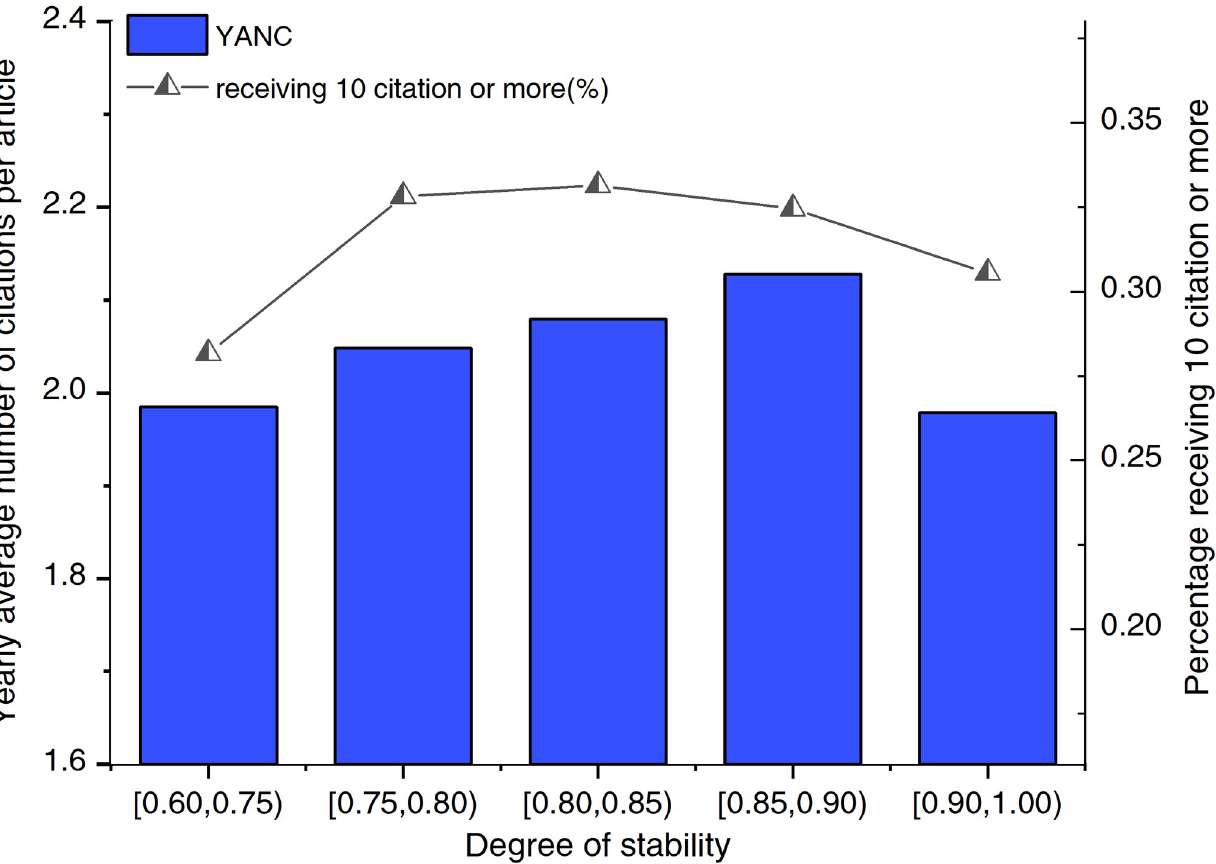
Fig 7. Yearly average number of citations (YANC) received and proportion of coauthored articles that have received at least 10 citations (CAP10C) per year for different stability groups in 1993–2013.